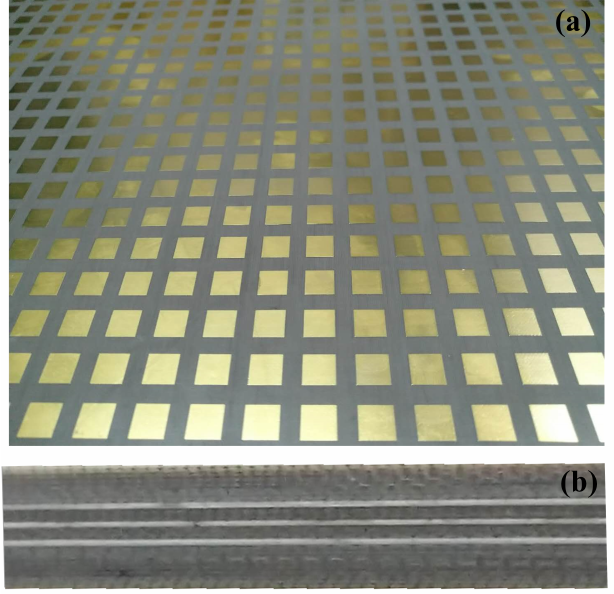
Figure 9. The fabricated sample of the cross-polarized converter: ( a ) Top view of the sample. ( b ) Side view of the